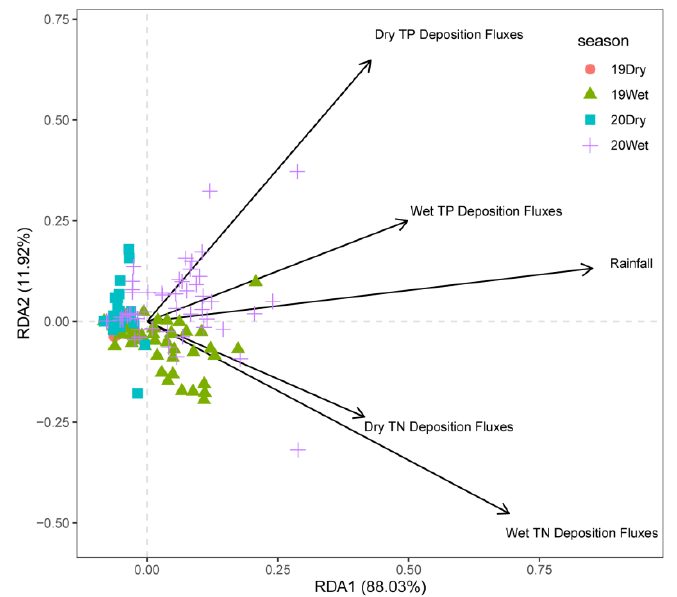
Figure 5. Redundancy analysis (RDA) of atmospheric nitrogen and phosphorus deposition and water quality factors in Henan Canal.